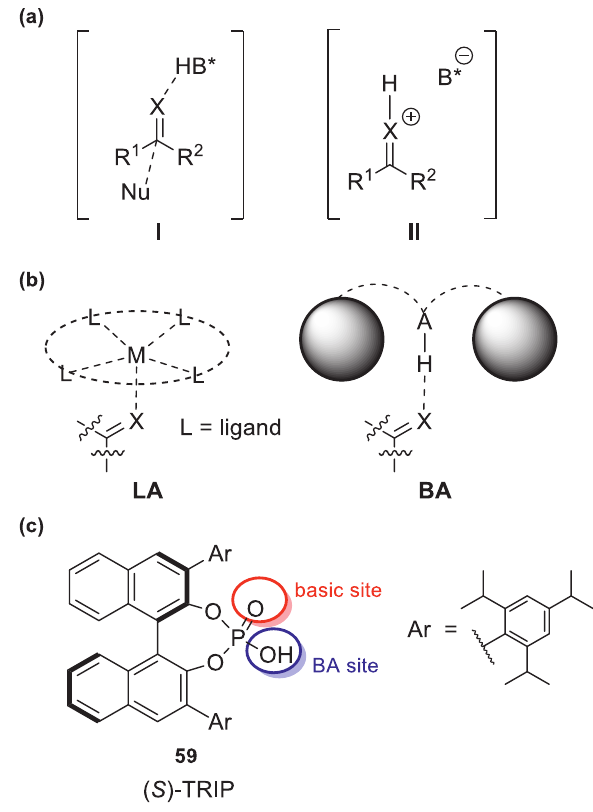
Figure 15 . (a) Transition states in general acid catalysis (I) and in speci fi c acid catalysis (II); (b) Lewis acid (LA) and Brønsted acid (BA) catalysts; c) ( S )-TRIP ((S)-3,3 ′ -Bis(2,4,6-triisopropylphenyl)- 1,1 ′ -binaphthyl-2,2 ′ -diyl